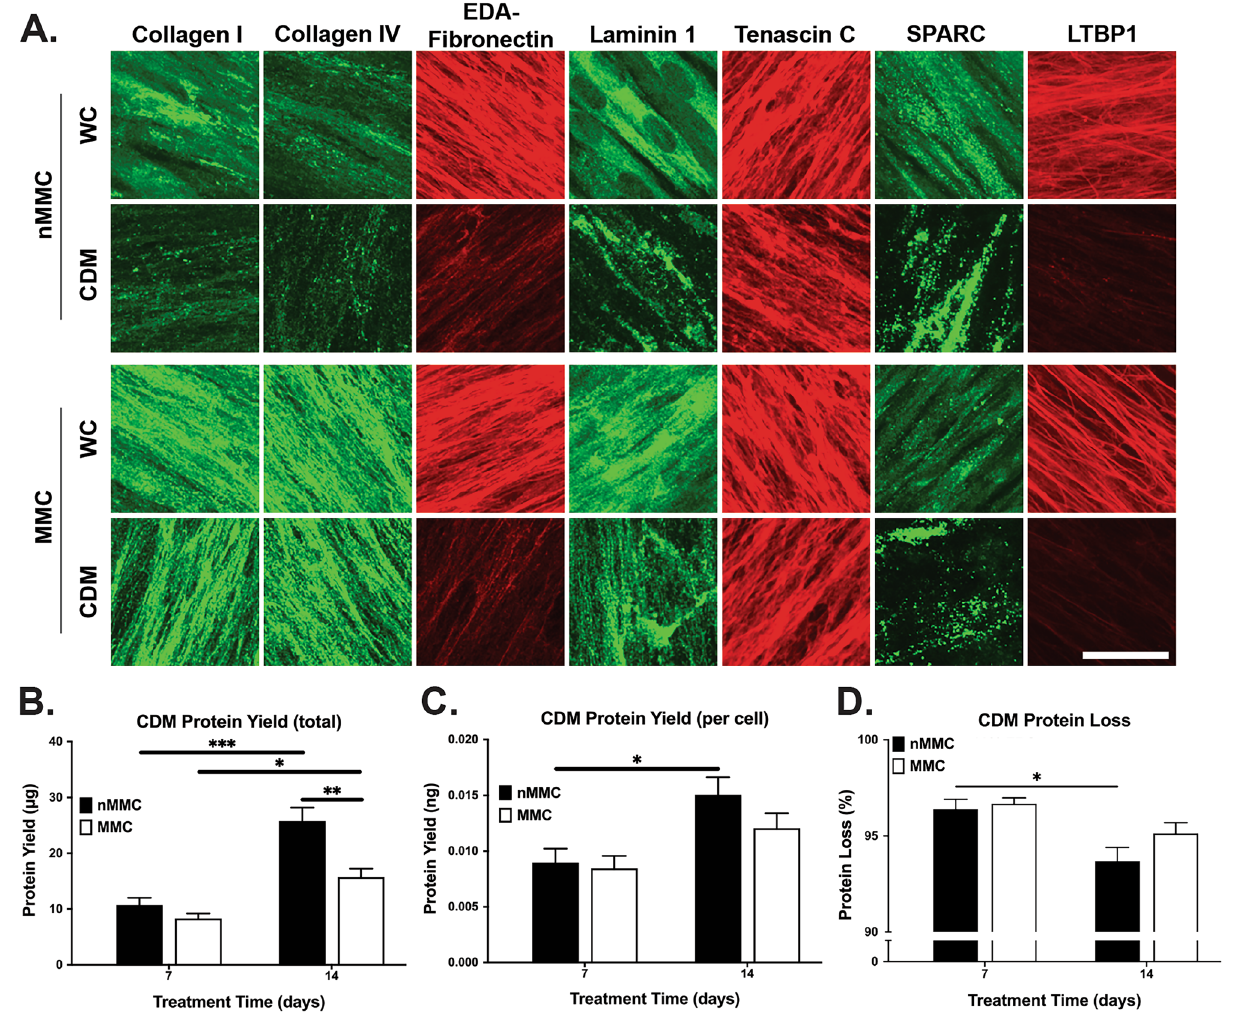
Figure 9. Characterization of cultures and CDMs generated in MMC and nMMC conditions before and after decellularization. ( A ) Representative standardized images of collagen I, collagen IV, cellular fibronectin (EDA- fibronectin), laminin 1, tenascin C, SPARC, and LTBP1 immunostaining in 14-day MMC and nMMC cultures with cells (WC) and after decellularization (CDM) from two repeated experiments. Magnification bar = 40 μm. ( B , C ) Comparison of total ( B ) and relative (normalized for cell numbers based on nuclear DAPI counts in parallel samples) ( C ) protein amount over time and between MMC and nMMC CDMs. ( D ) Comparison of total protein loss due to decellularization over time between MMC and nMMC CDMs. Results show total protein amount (mean + /− SEM) from CDMs relative to corresponding cultures with cells (= 100%) as determined by Bradford assay. ( B – D ) Results show mean + /− SEM from 6 repeated experiments. Statistical testing between time points was performed by one-way ANOVA and between treatments at each time point by independent samples t-test, *p < 0.05; **p < 0.01; ***p <